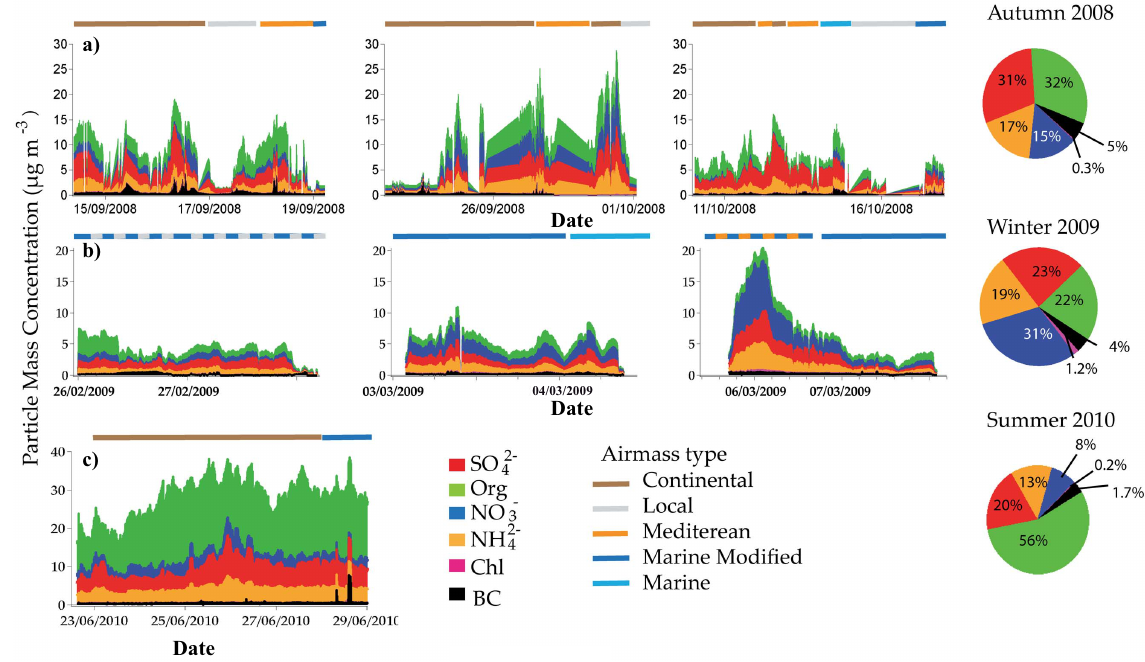
Fig. 2. Mass concentration of organic and inorganic particles measured by the AMS, and BC measured by MAAP during autumn, winter, and summer. Pie charts illustrate the average particle composition measured during each campaign. Coloured bars at the top of each graph indicate the source of the airmass. When the bars are multicoloured it indicates that the airmasses were mixed during this period of